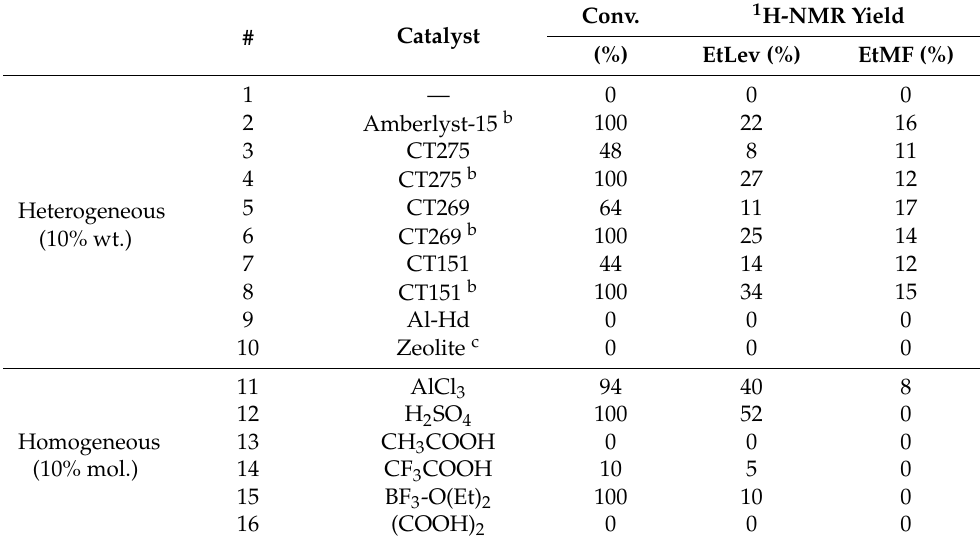
Table 1. Synthesis of EtLev in presence of heterogenous and homogenous acid catalysts a .